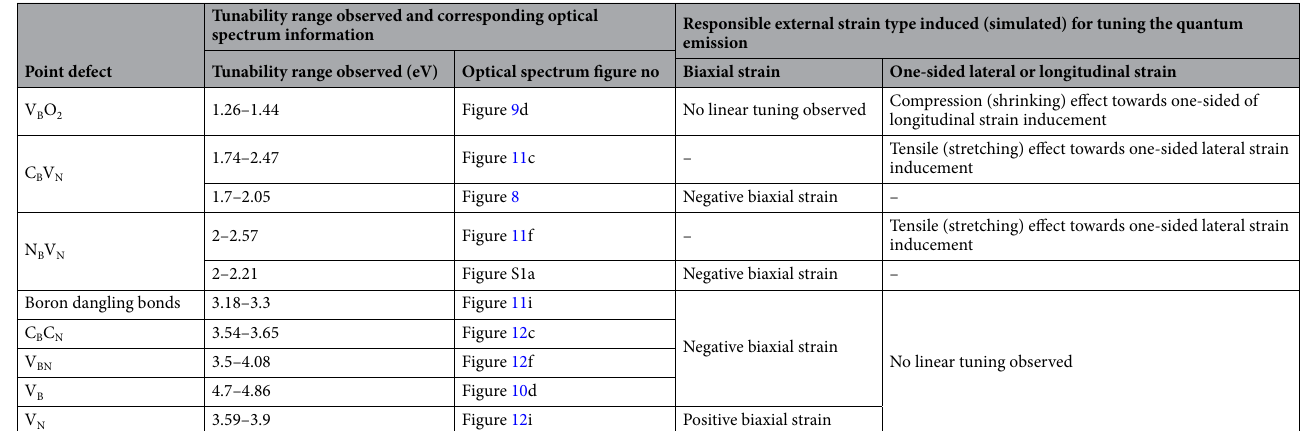
Table 4. Information related to quantum emission tunability range towards higher energy region and responsible external strain